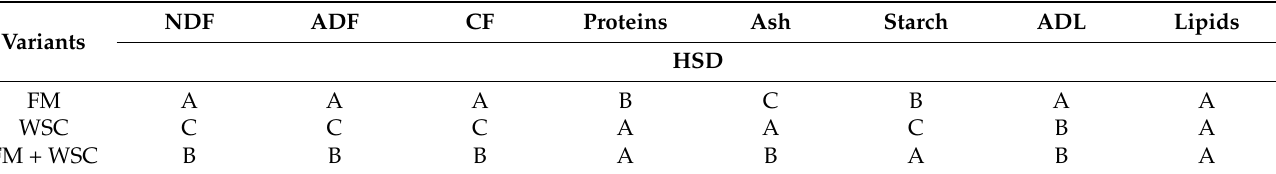
Table 4. Significant differences between the individual variants.